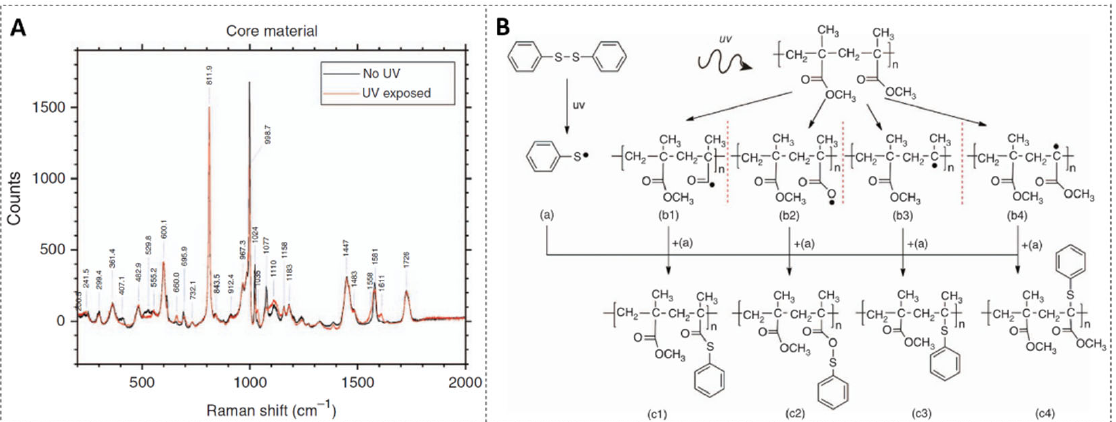
Figure 3. ( a ) 4-stilbenemethanol isomerization from trans to cis under UV irradiation [27,48]. ( b ) Energy level scheme involved in the photoisomerization process of the TS compound. Reprinted with permission from [29].